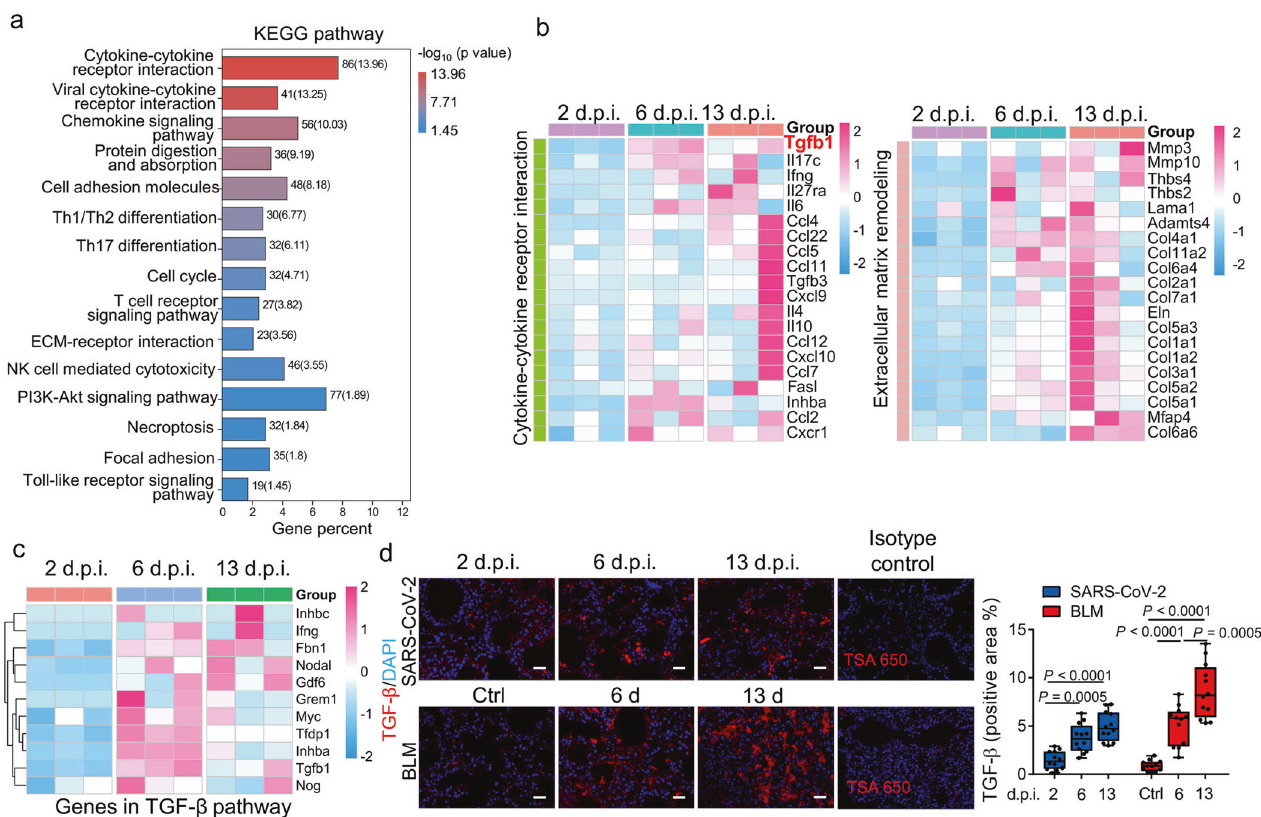
Fig. 2 hCD147 mice with SARS-CoV-2 infection showed fi brotic characteristics revealed by RNA-seq analysis. a KEGG enrichment analysis of pathways enriched in differentially expressed genes in three pro fi les showing increasing trends. b Heatmap of signi fi cantly enriched genes involved in cytokine-cytokine receptor interaction and ECM remodeling in the three pro fi les. c Heatmap of signi fi cantly enriched genes involved in TGF- β pathway. d Immuno fl uorescence staining and quanti fi cation of TGF- β in lung tissue sections from SARS-CoV-2-infected hCD147 mice and bleomycin-induced pulmonary fi brosis model at indicated time points. The rabbit IgG isotype control was used along with the staining of TGF- β . Scale bars, 50 μ m. n = 12 images for each group, one-way ANOVA followed by multiple